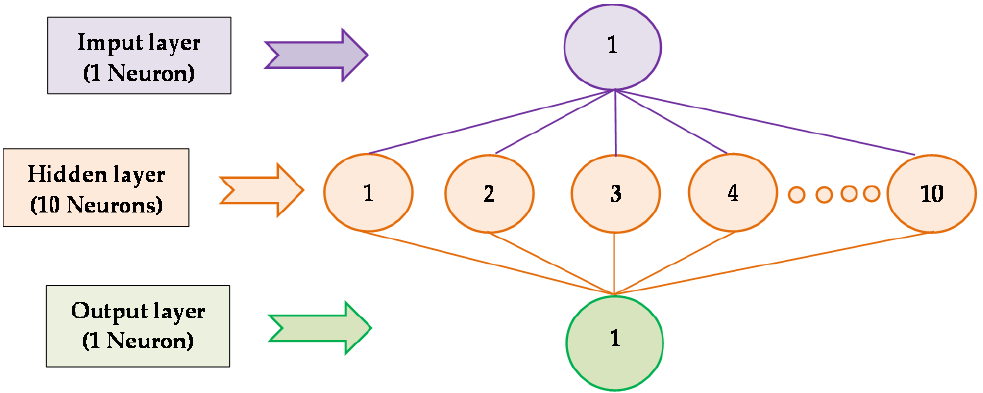
Figure 5. Schematic of Artificial Neural Networks (ANN) model architecture for BRC beam and SRC beam.